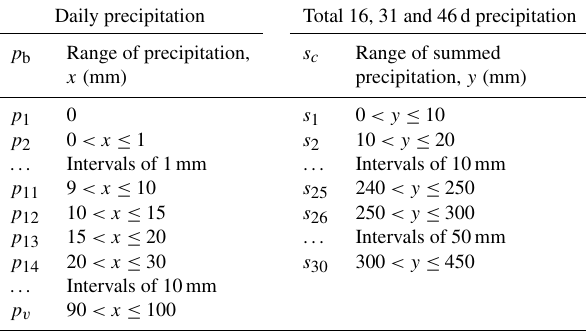
Table 1. Range of daily precipitation, x , for each bin p b and of 16, 31 and 46d total precipitation, y , for each bin s c